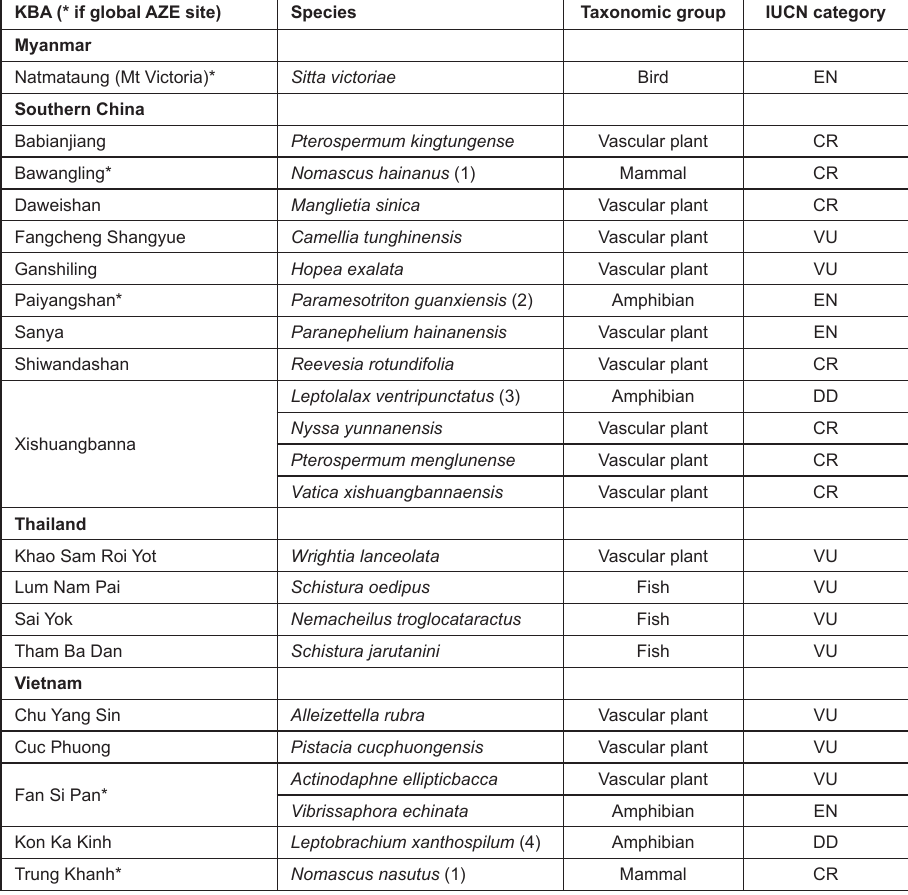
Table 5. Trigger species occurring at only one KBA globally, and the KBAs they trigger KBA (* if global AZE